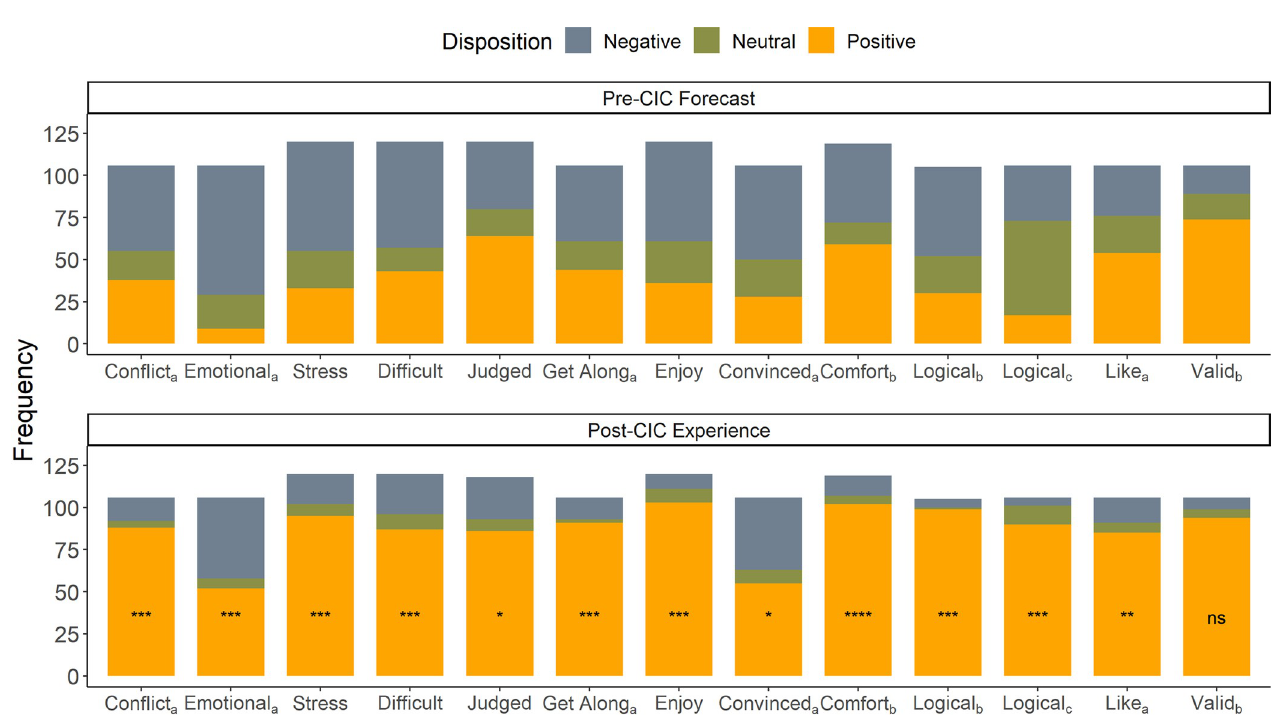
Fig 2. Proportion of disposition for pre-CIC and post-CIC forecasted/experienced variables. Note . Chi-square analysis of each variable ( n = 120) was significant for a difference in the proportion of disposition. Looking at the graph a larger proportion of responses look to be in the positive disposition post- CIC. Pairwise analysis of the negative vs positive proportion (noted by Bonferroni adjusted p-value asterisks) and the neutral vs positive proportion confirmed the omnibus test, such that a larger portion of positive disposition compared to either negative or neutral disposition was the direction of change. � p < .05 with Bonferroni correction. �� p < .01 with Bonferroni correction, ��� p < .001 with Bonferroni correction, a Sample size is n = 106, b Sample size n = 105, c Sample size n =